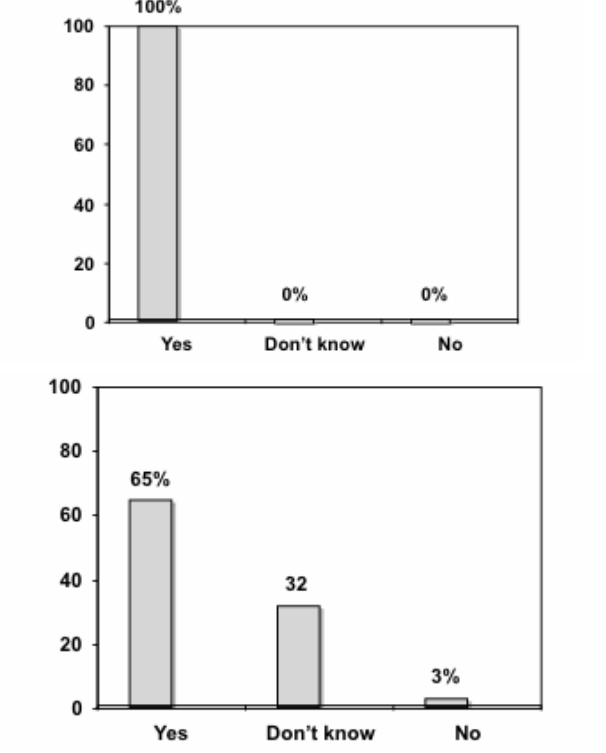
Figure 3: Did Mindmanager X5 Pro Add Any Value As A Communication